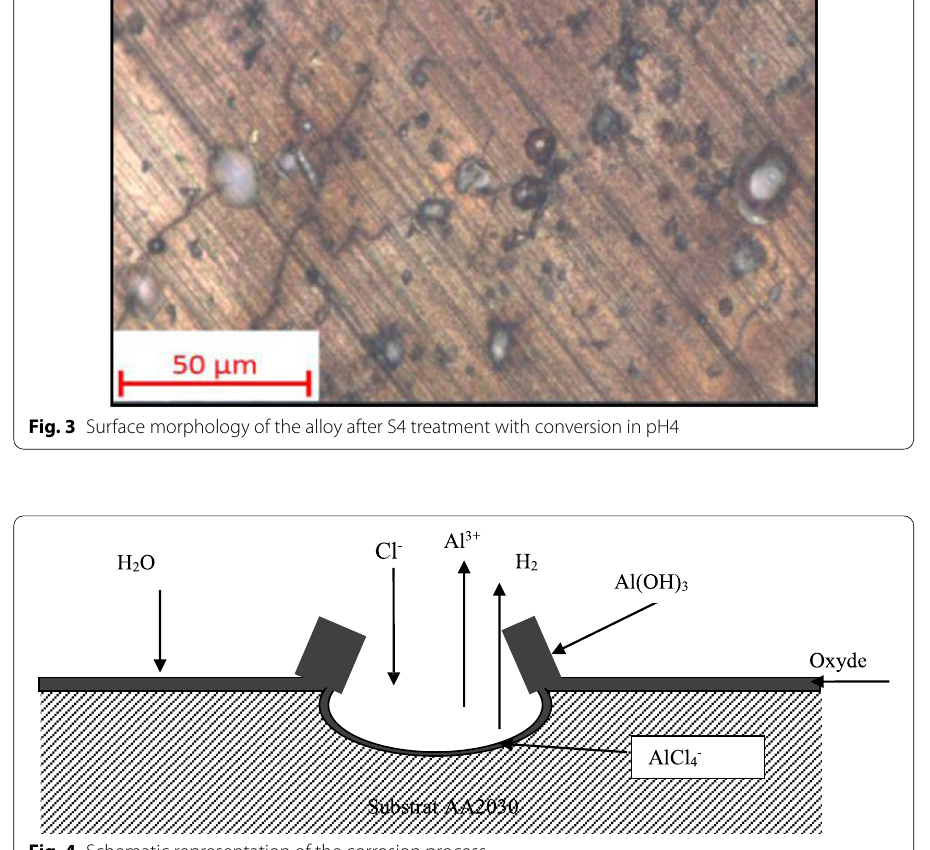
Fig. 4 Schematic representation of the corrosion